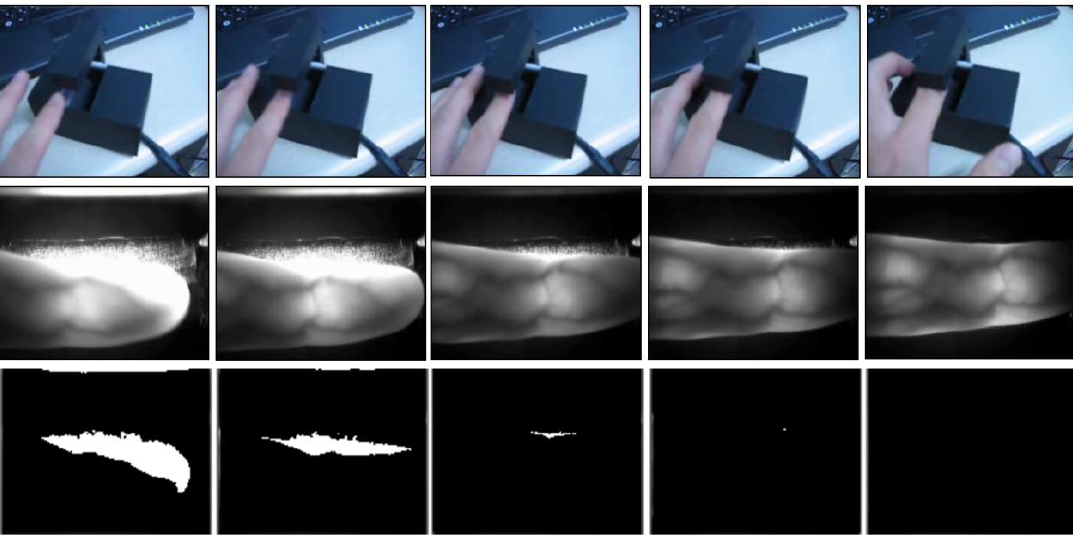
Figure 3. Procedure used for acquiring an adequate finger image from successive images. The first row shows successive images of a user placing his finger on the device.